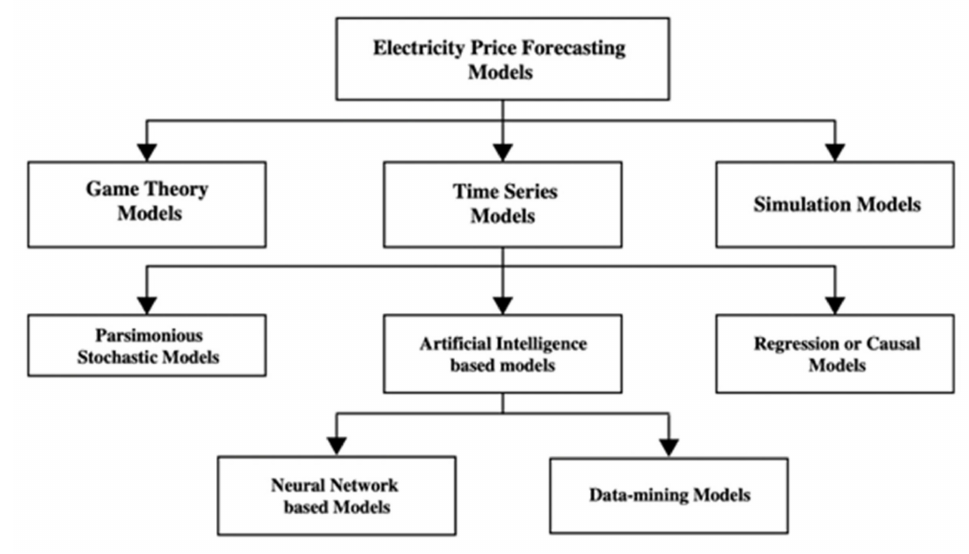
Figure 1. Electricity price forecasting models